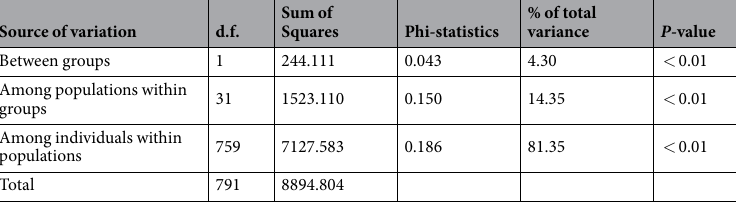
Table 2. Hierarchical analysis of molecular variance based on 12 microsatellite loci and 33